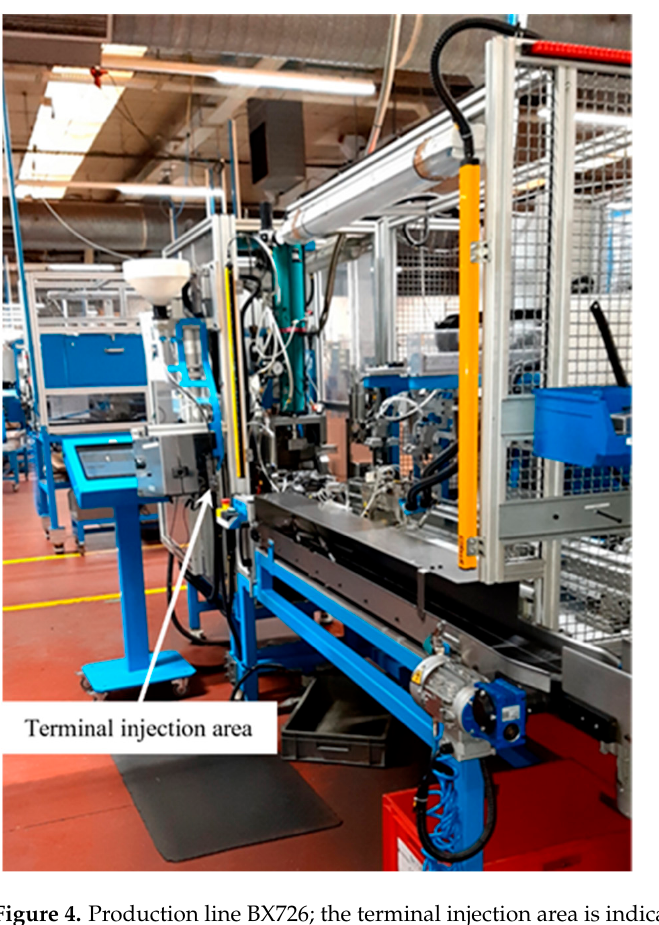
Figure 4. Production line BX726; the terminal injection area is indicated.